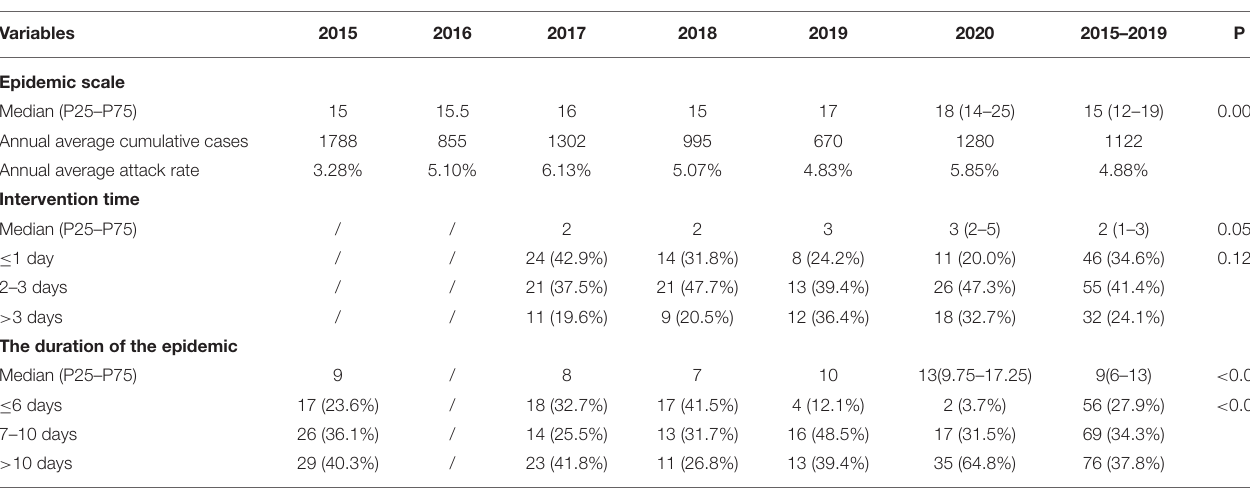
TABLE 1 | Epidemiological characteristics of clusters from 2015 to